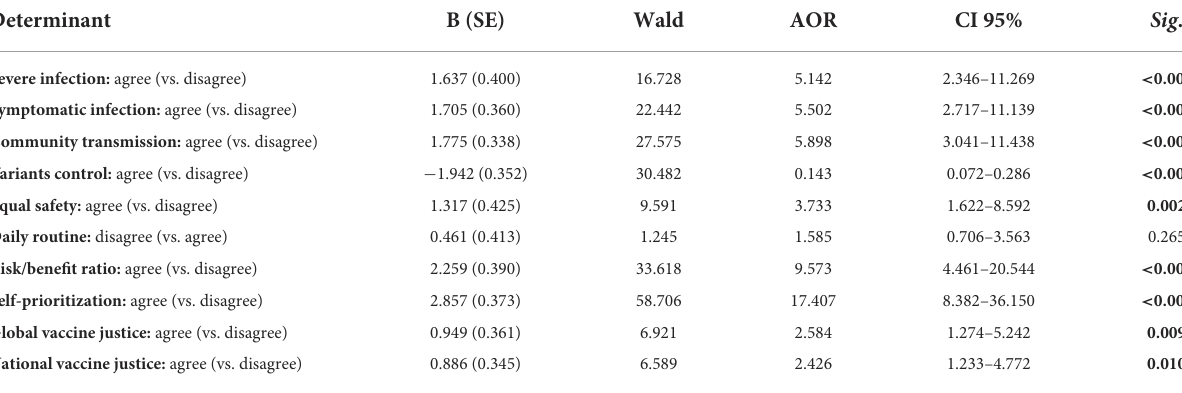
TABLE 8 Psychosocial determinants of COVID-19 vaccine booster acceptance among polish healthcare professionals and students responding to COVID-19 VBH survey, December 2021–January 2022 ( n = 443). Determinant B (SE) Wald AOR CI 95% Sig .